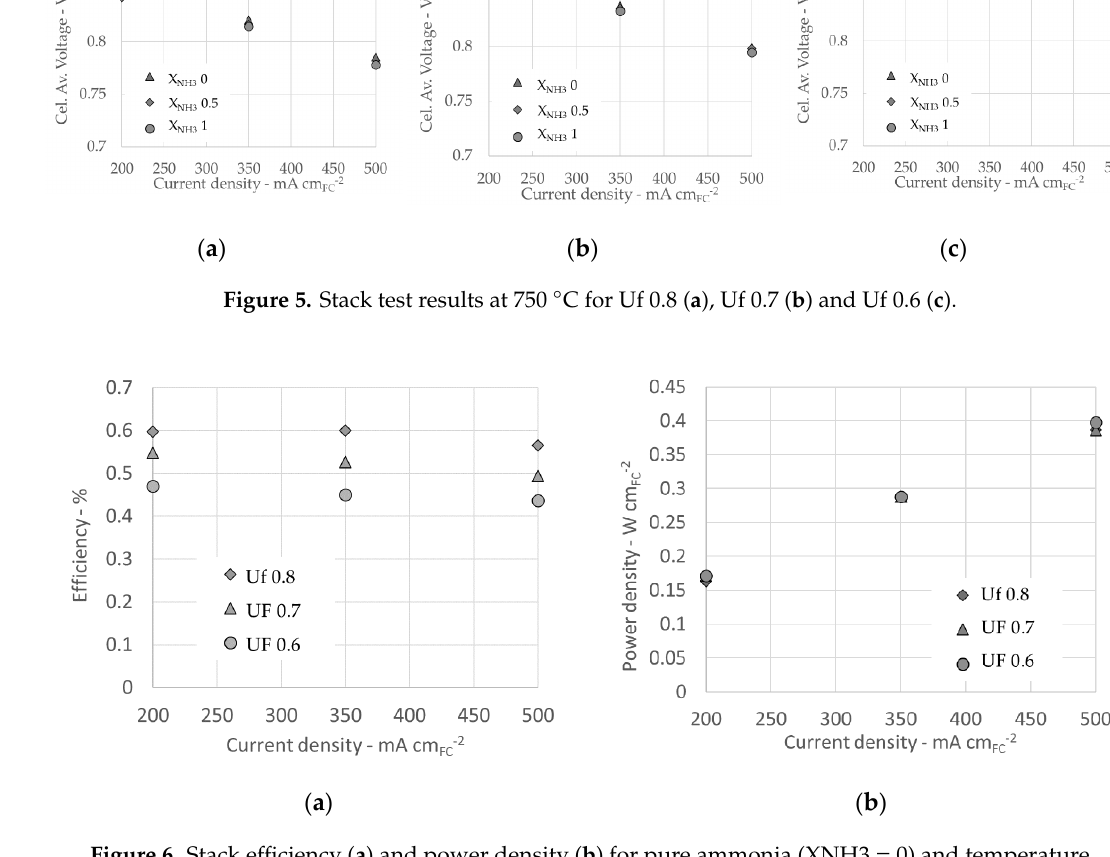
Figure 5. Stack test results at 750 °C for Uf 0.8 ( a ), Uf 0.7 ( b ) and Uf 0.6 ( c ).